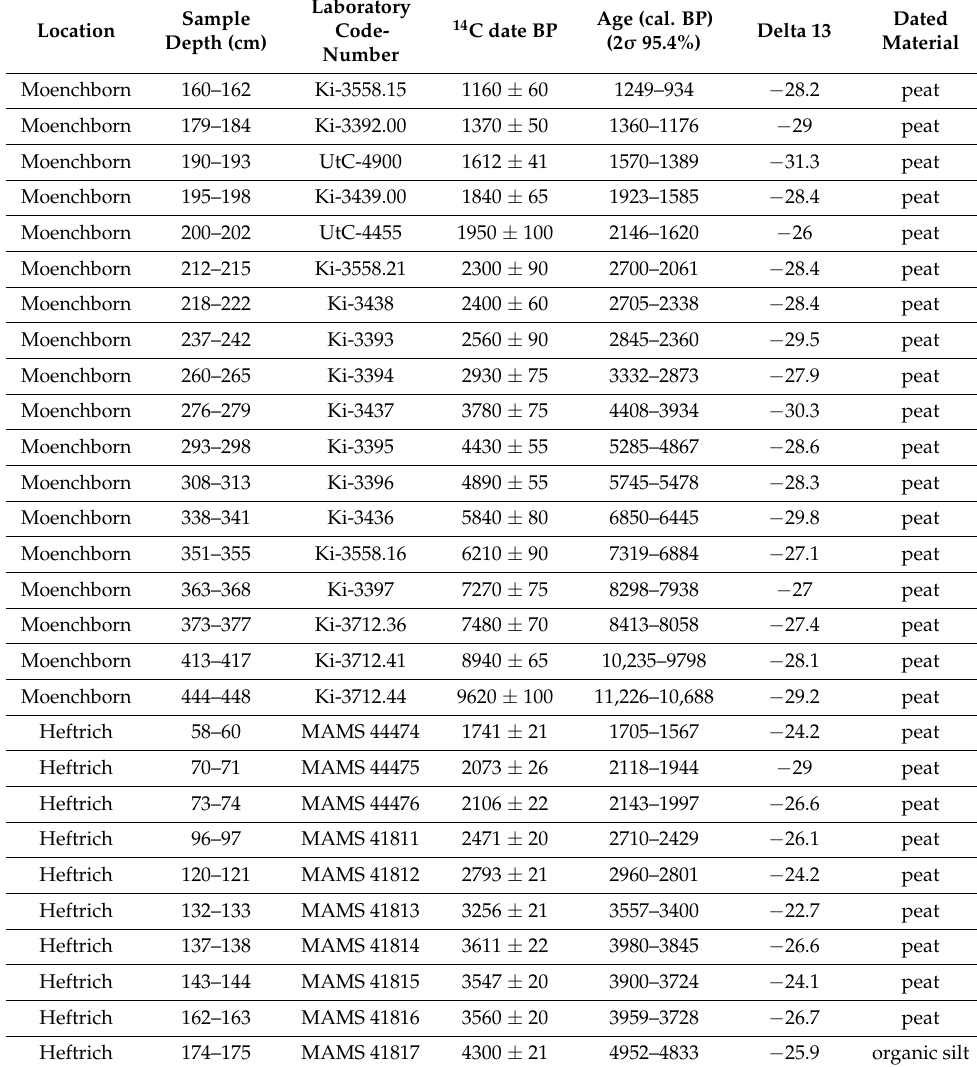
Table 1. Radiocarbon dates from the profiles Moenchborn and